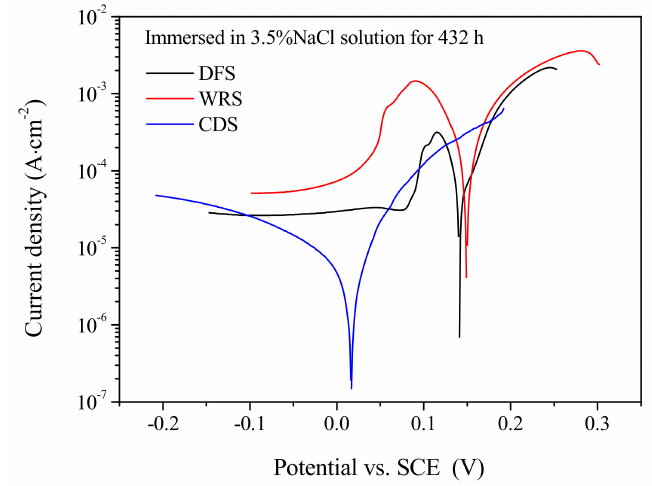
Figure 11. The polarization curves of DFS, WRS and CDS immersed in 3.5% NaCl solution for 432 h.